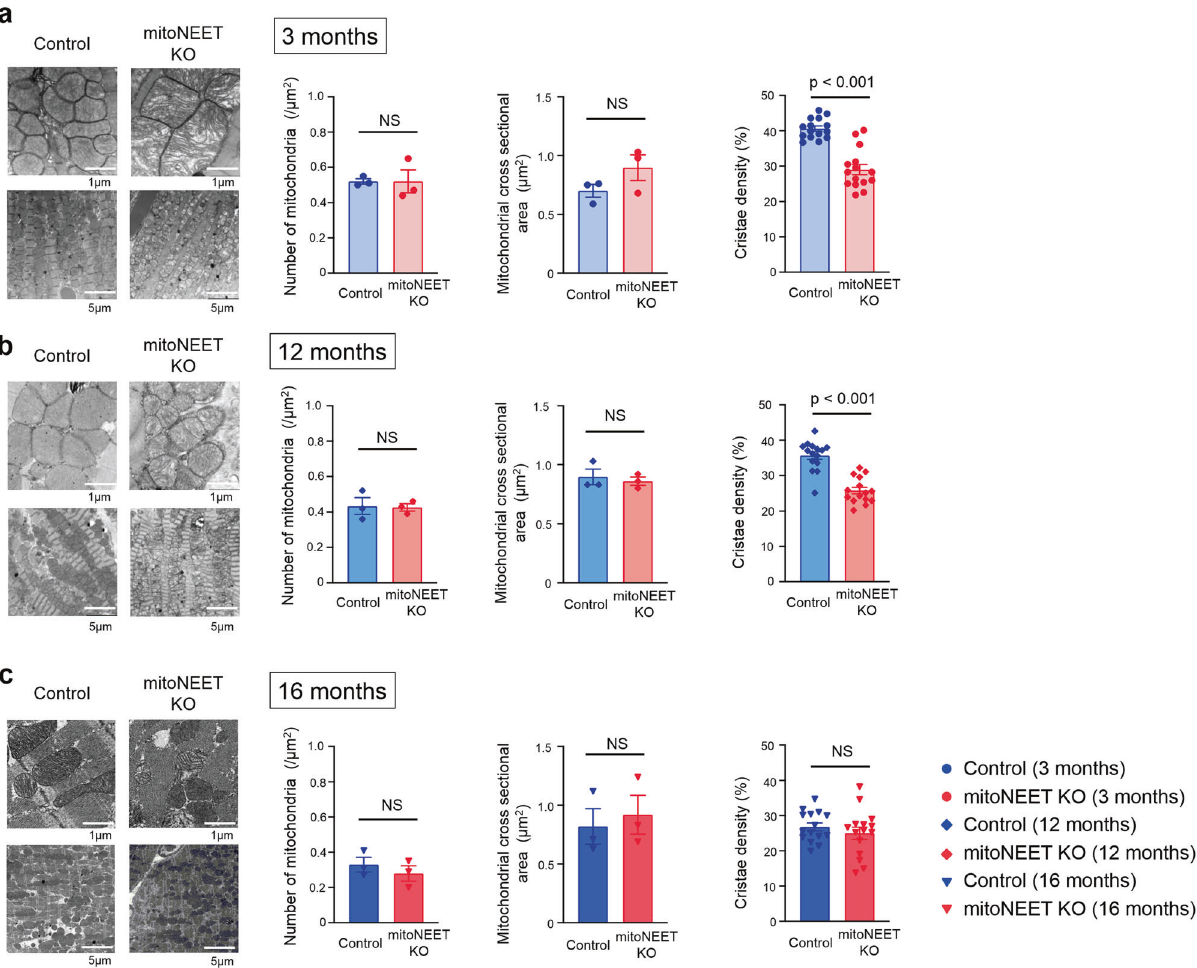
Fig. 4 MitoNEET KO mice have abnormal mitochondrial morphological integrity. Representative electron microscopic images and summary data of the number of mitochondria, mitochondrial size, and cistae density in Control and mitoNEET KO mice at 3 months ( a ; n = 3 each), 12 months ( b ; n = 3 each), and 16 months of age ( c ; n = 3 each). Data are shown as the mean ± s.e.; individual data points are shown. The Student unpaired two-tailed t -test was performed to compare means between Control and mitoNEET KO mice of identical age. NS, not signi fi